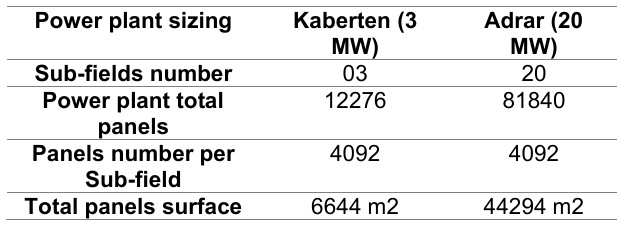
Table 11: PV power plant